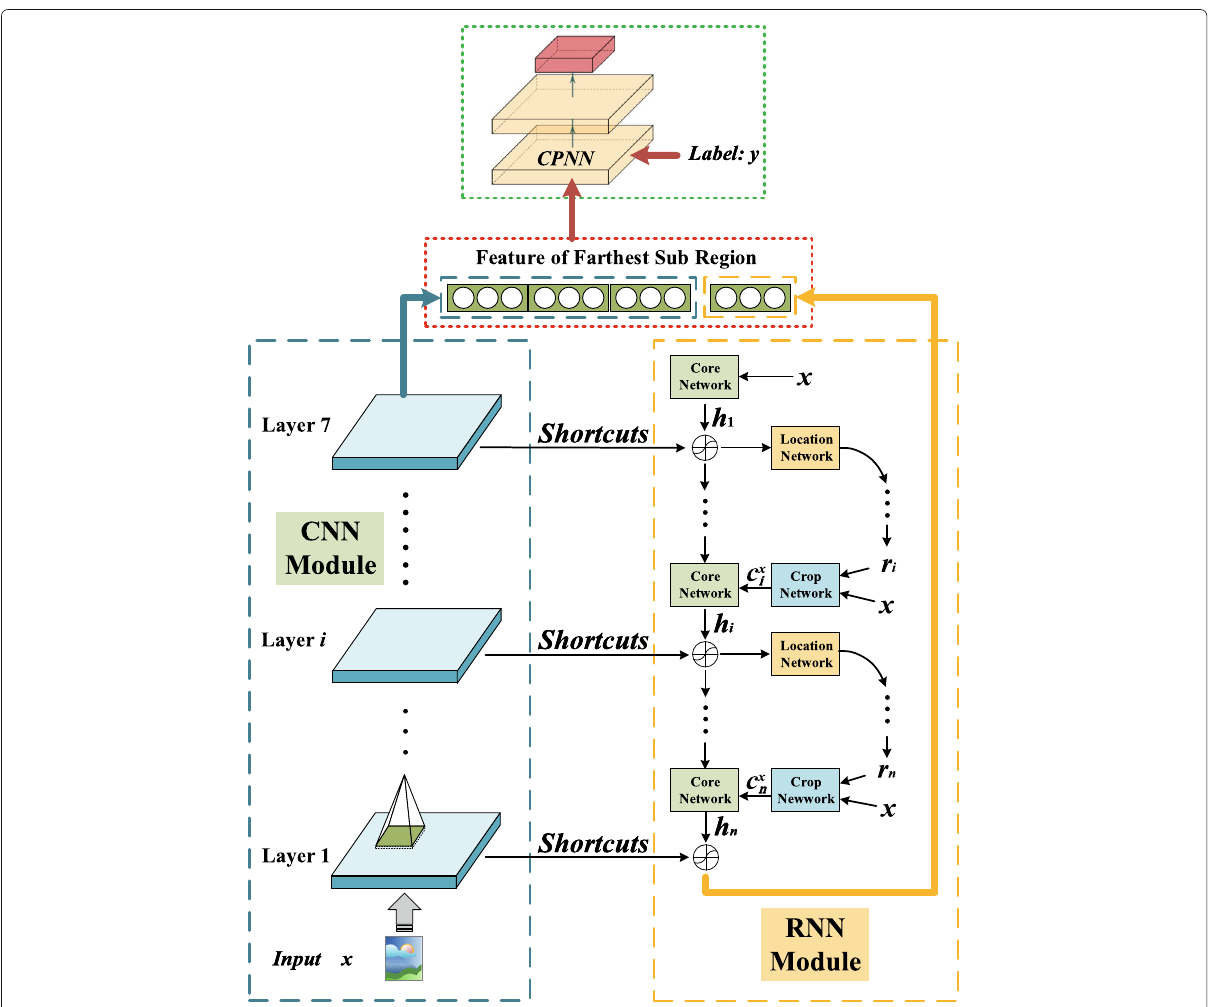
Fig. 4 Our architecture contains three modules: CNN module, RNN module, and CPNN layer